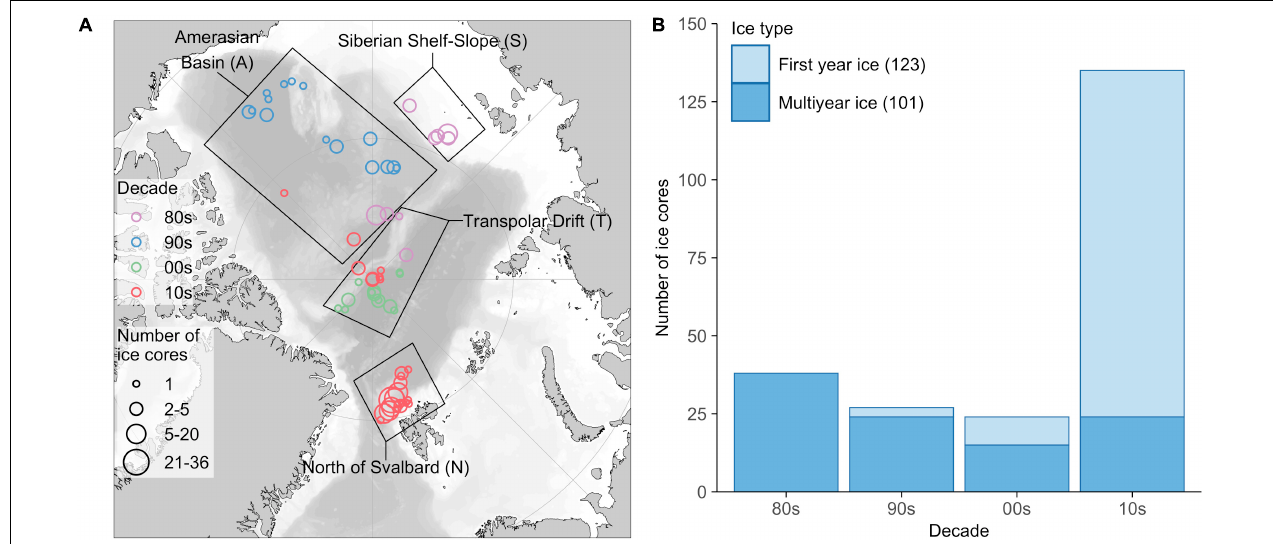
FIGURE 1 | Sample overview. (A) Location, time period and number of ice cores used in this study binned using 2 ◦ resolution. Color indicates the decade when ice cores were sampled and size of a circle the number of ice cores. Black rectangles represent the regions used for data categorization. (B) Allocation of ice cores to ice type (first-year ice, multiyear ice) by decade. Numbers in brackets indicate the total number of ice cores for each ice type. The map was created using the PlotSvalbard package (Vihtakari, 2018) with GEBCO one-minute grid and Natural Earth data for bathymetry (https://www.gebco.net/data_and_products/ gridded_bathymetry_data/gebco_one_minute_grid/) and land shapes (http://www.naturalearthdata.com/downloads/50m-physical-vectors/).